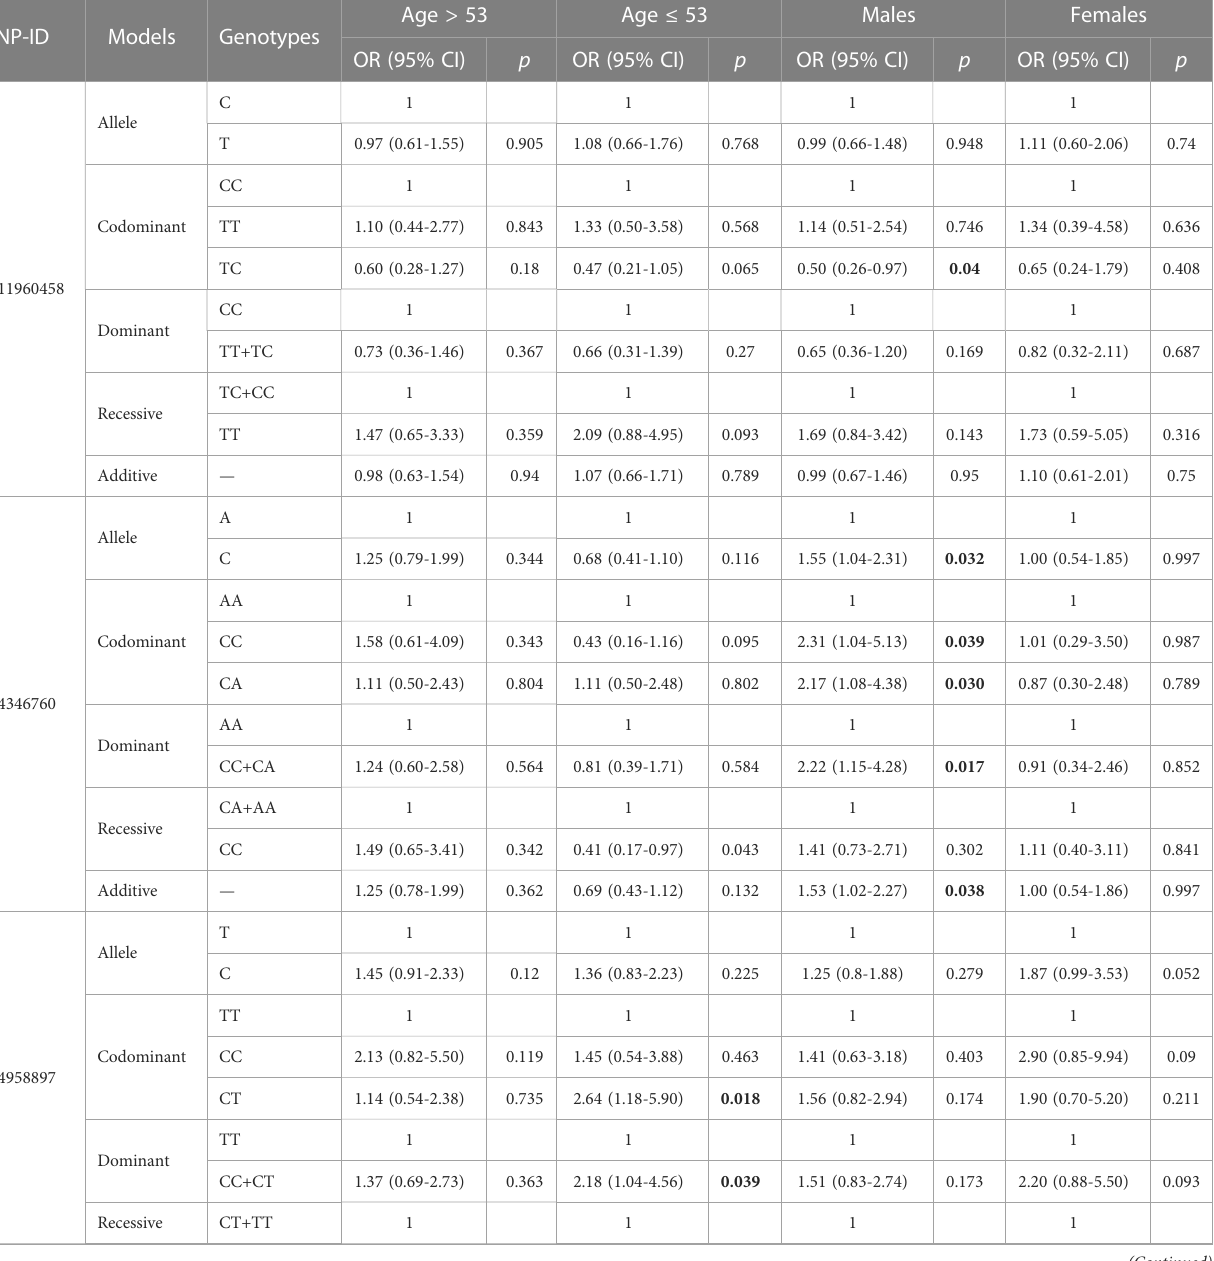
TABLE 4 Correlation of ANXA6 variants with HNC risk strati fi ed by age and